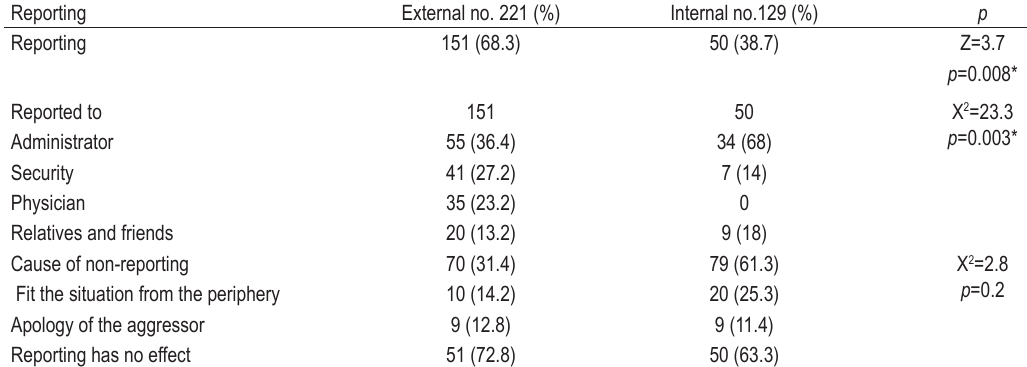
TABLE 3. Frequency of reporting of external and internal violence against nurses and causes of non-reporting, Minia district